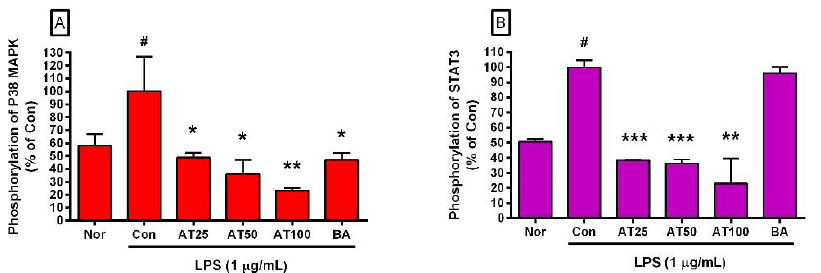
Figure 6. P38 MAPK phosphorylation ( A ) and STAT3 phosphorylation ( B ) in RAW 264.7 activated by LPS. Values are presented as mean ± SD. Nor, the group treated with cell culture media alone; Con, the group treated with lipopolysaccharide (LPS, 1 µg/mL) alone. AT25 means 25 µg/mL of AT, AT50 means 50 µg/mL of AT, and AT100 means 100 µg/mL of AT. BA, baicalein (25 µM). #, p < 0.05 vs. Nor; *, p < 0.05 vs. Con; **, p < 0.01 vs. Con; ***, p < 0.001 vs. Con.